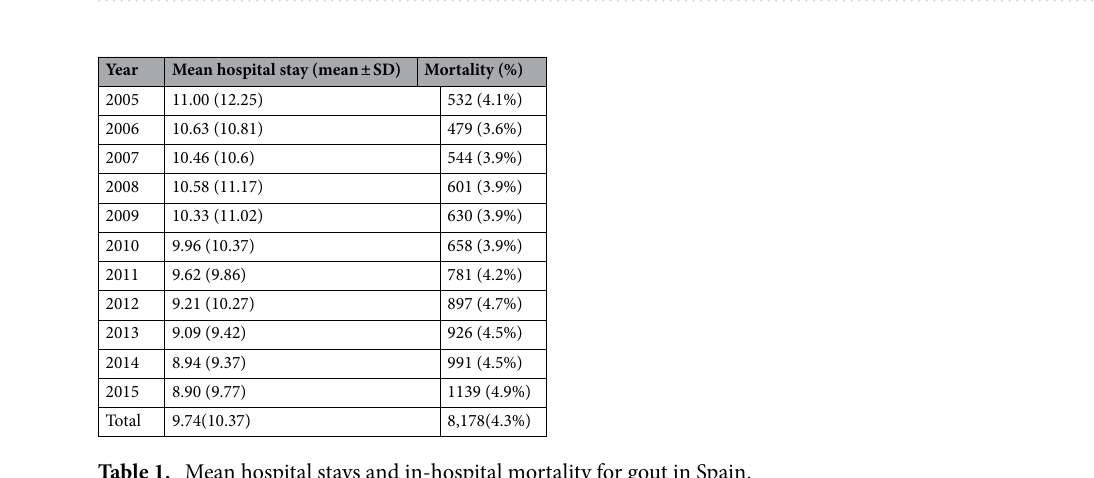
Figure 1. (A) Number of hospitalizations by year in Spain. (B) Hospitalization rate per 10,000 hospitalizations by year in the MBDS.